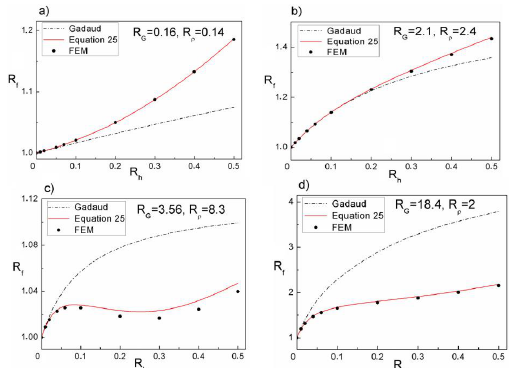
Figure 2. Evolution of the frequency ratio as a function of the thicknesses ratio for: ( a ) (cid:1844) (cid:3008) = 0.16, (cid:1844) (cid:3096) = 0.14 ; ( b ) (cid:1844) (cid:3008) = 2.1, (cid:1844) (cid:3096) = 2.4 ; ( c ) (cid:1844) (cid:3008) = 3.56, (cid:1844) (cid:3096) = 8.3 ; ( d ) (cid:1844) (cid:3008) = 18.4, (cid:1844) (cid:3096) = 2 .